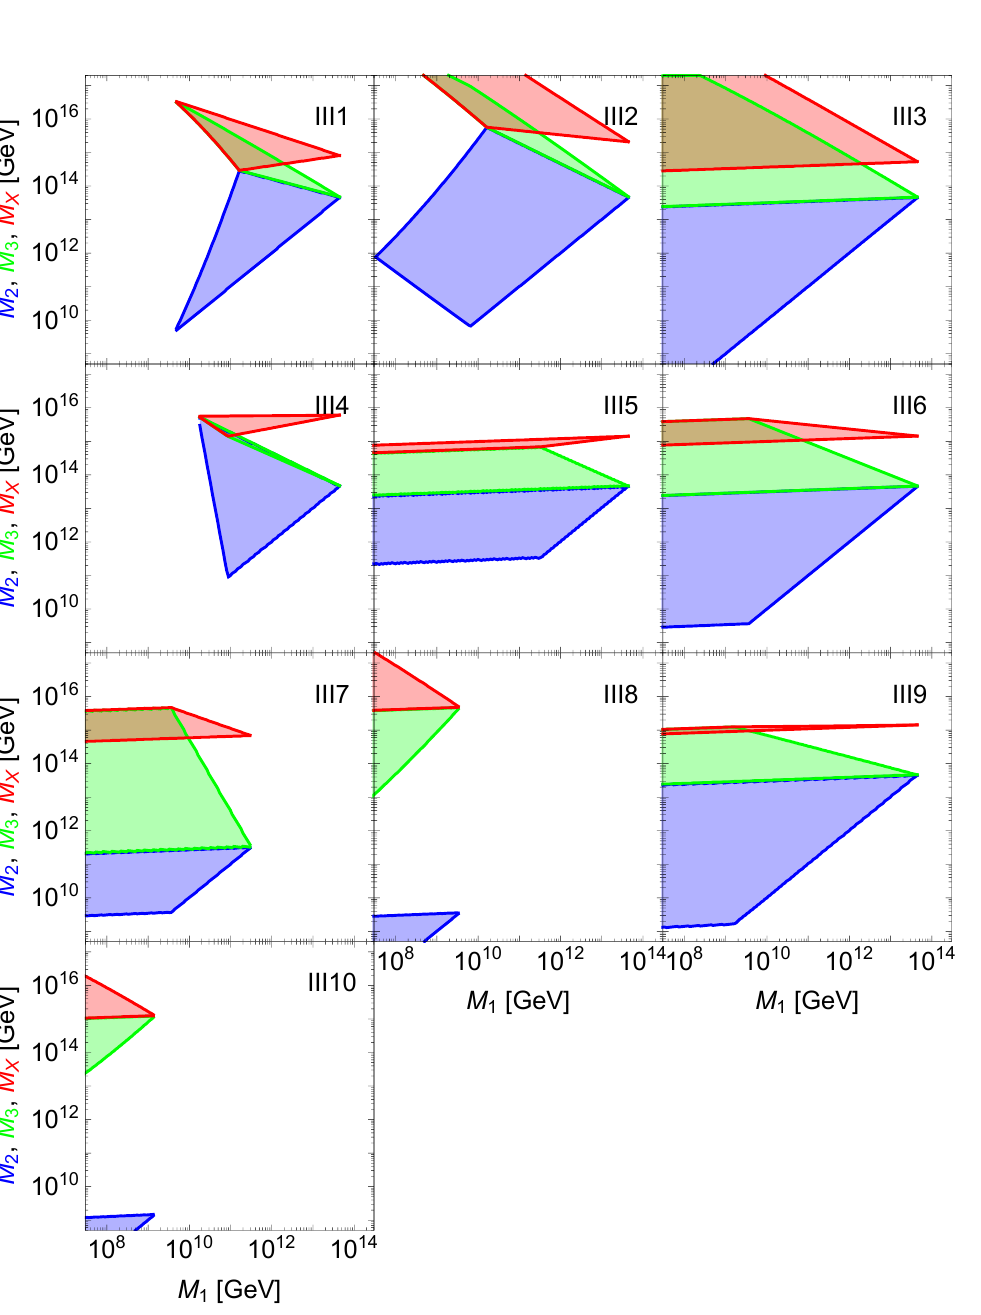
M 3 −−→ G M 2 −−→ G M 1 −−→ G . The 3 2 1 SM